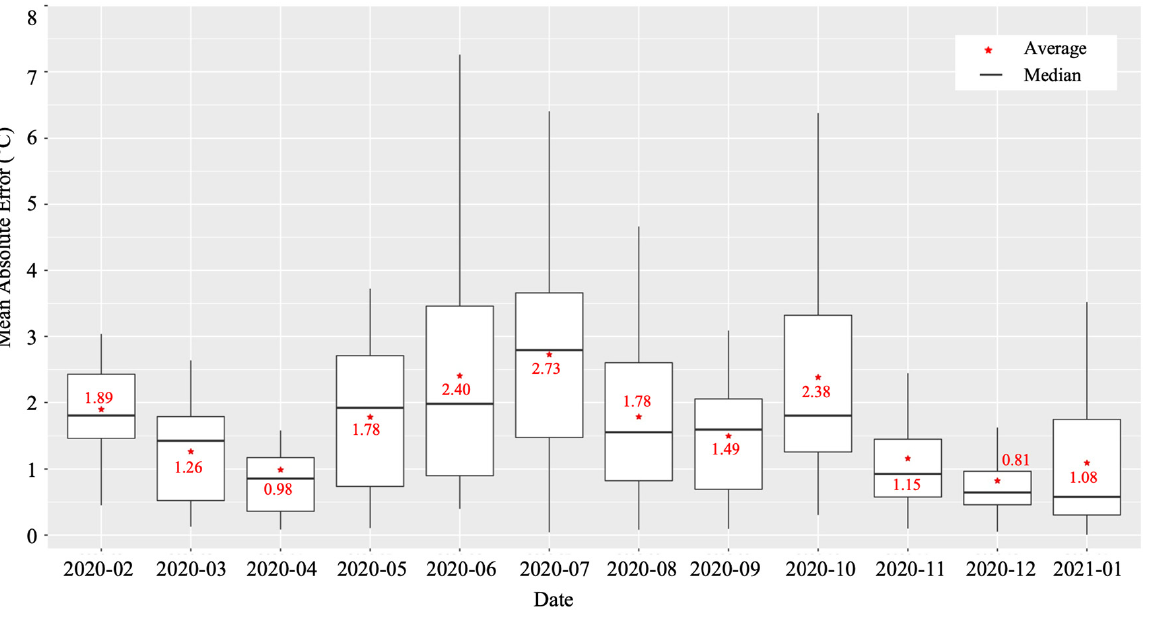
Figure 15. Monthly Mean Absolute Error (MAE) of the prediction model of the T4 temperature sensor.